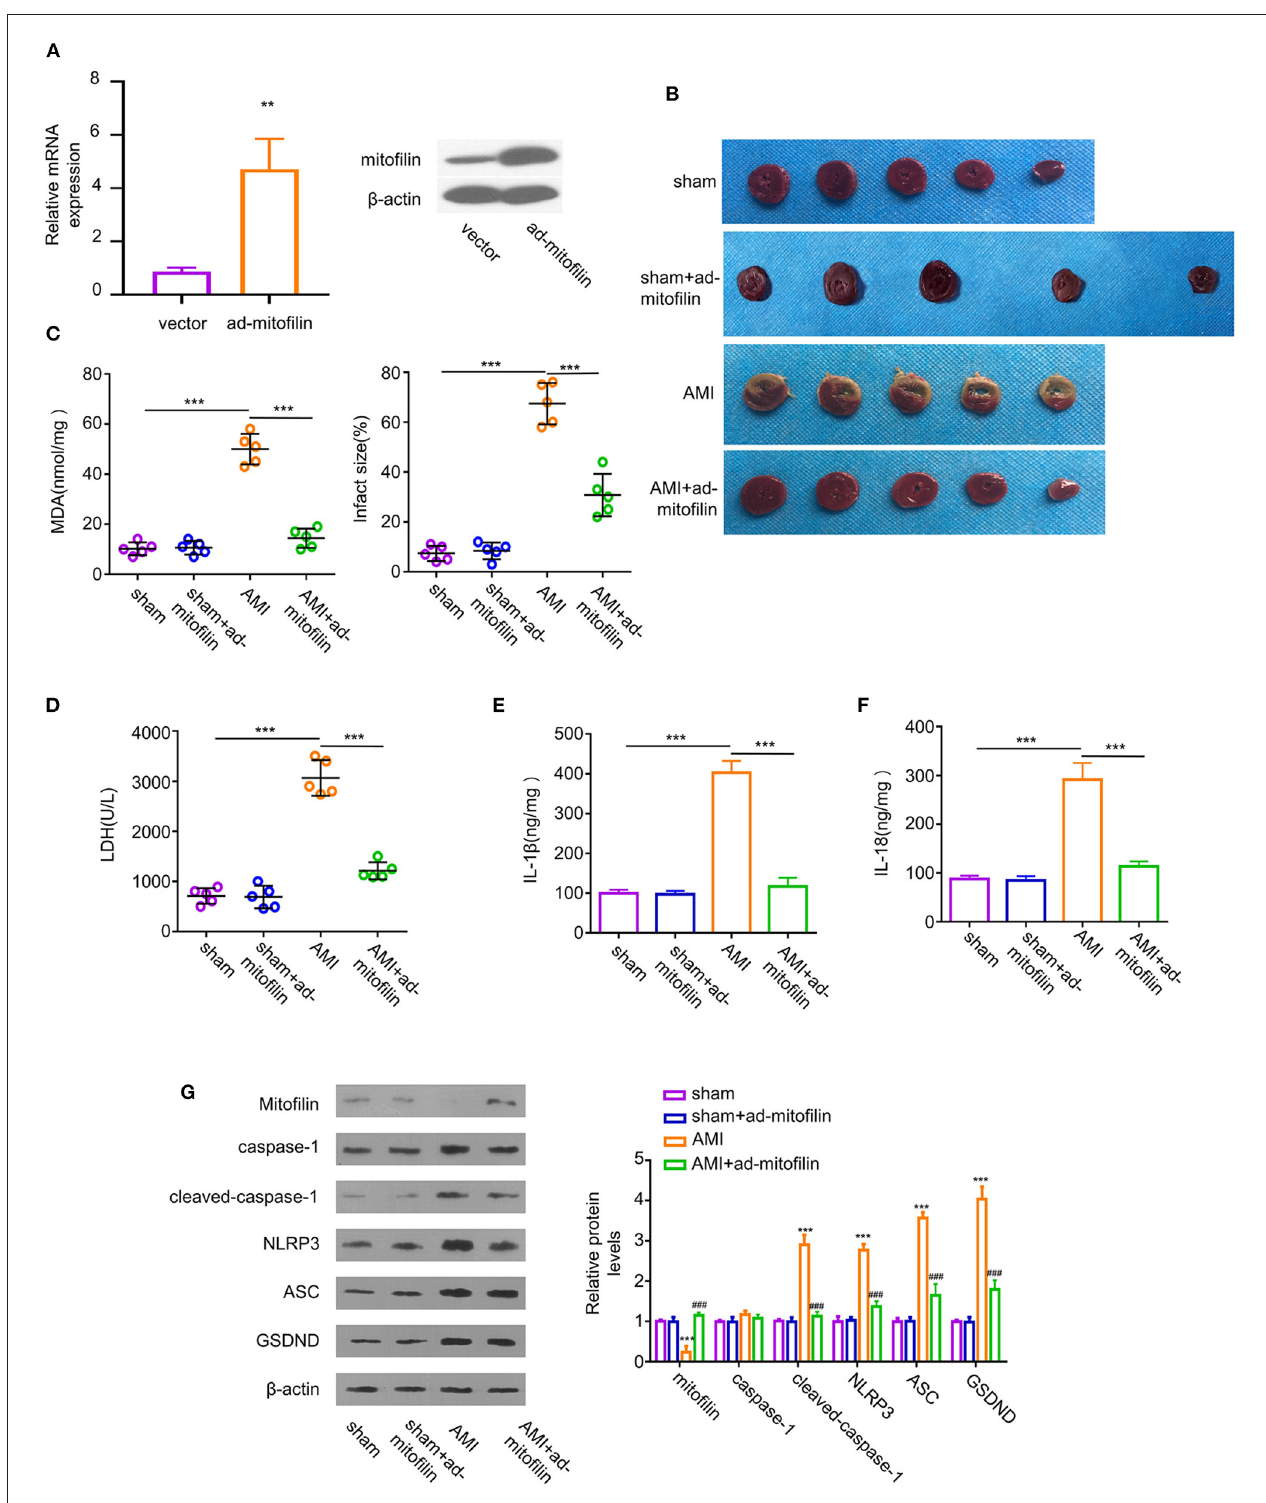
FIGURE 2 | Overexpression of mitofilin alleviates AMI. (A) The administration of adenovirus carrying mitofilin (ad-mitofilin) significantly increased the expression level of mitofilin in the myocardium. (B) The area of MI was partially reduced after the administration of ad-mitofilin. (C,D) MDA levels and LDH levels were partially reduced after the administration of ad-mitofilin. (E,F) IL-1 β and IL-18 levels were partially reduced after the administration of ad-mitofilin. (G) After the administration of ad-mitofilin, the mitofilin protein level was significantly increased upon AMI induction, while the protein levels of cleaved- caspase-1, NLRP3, ASC, and GSDND protein levels were partially decreased. Sham vs AMI: ** P < 0.01 and *** P < 0.001. AMI vs AMI + ad-mitofilin: ### P < 0.001.